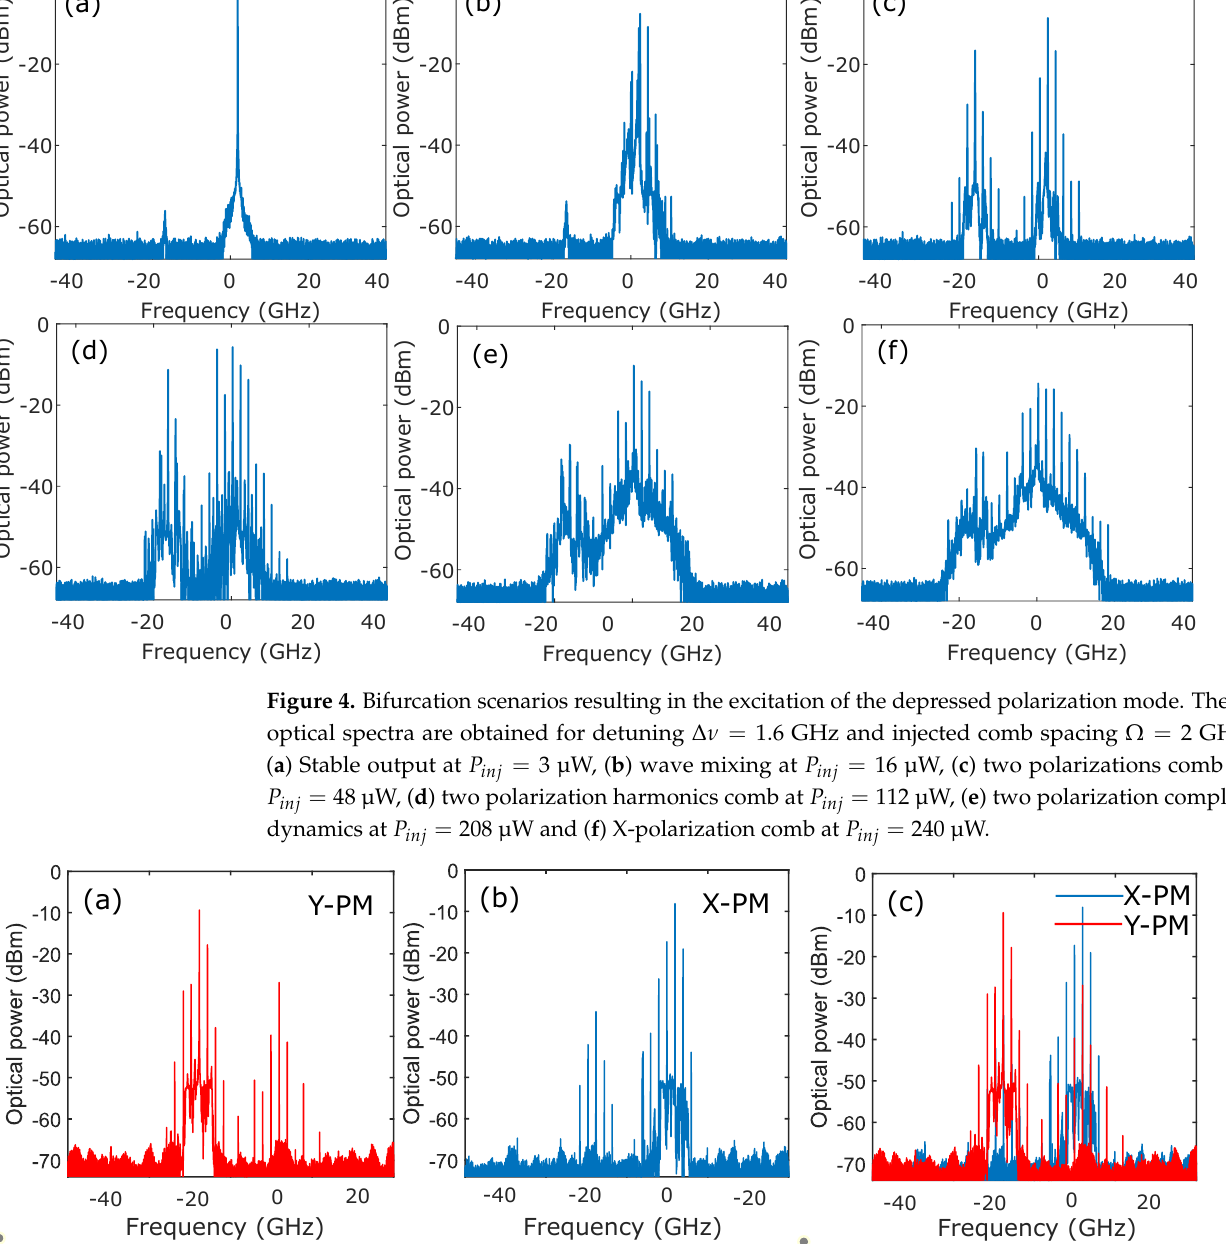
Figure 5. Polarization resolved-optical spectra corresponding to an example of two polarization comb dynamics in Figure 4c. ( a – c ) are obtained for detuning ∆ ν = 1.6 GHz and injected power P inj = 20 µW. ( a – c ) correspond to the optical spectra of Y-PM, X-PM and the superposition of Y-PM and X-PM,